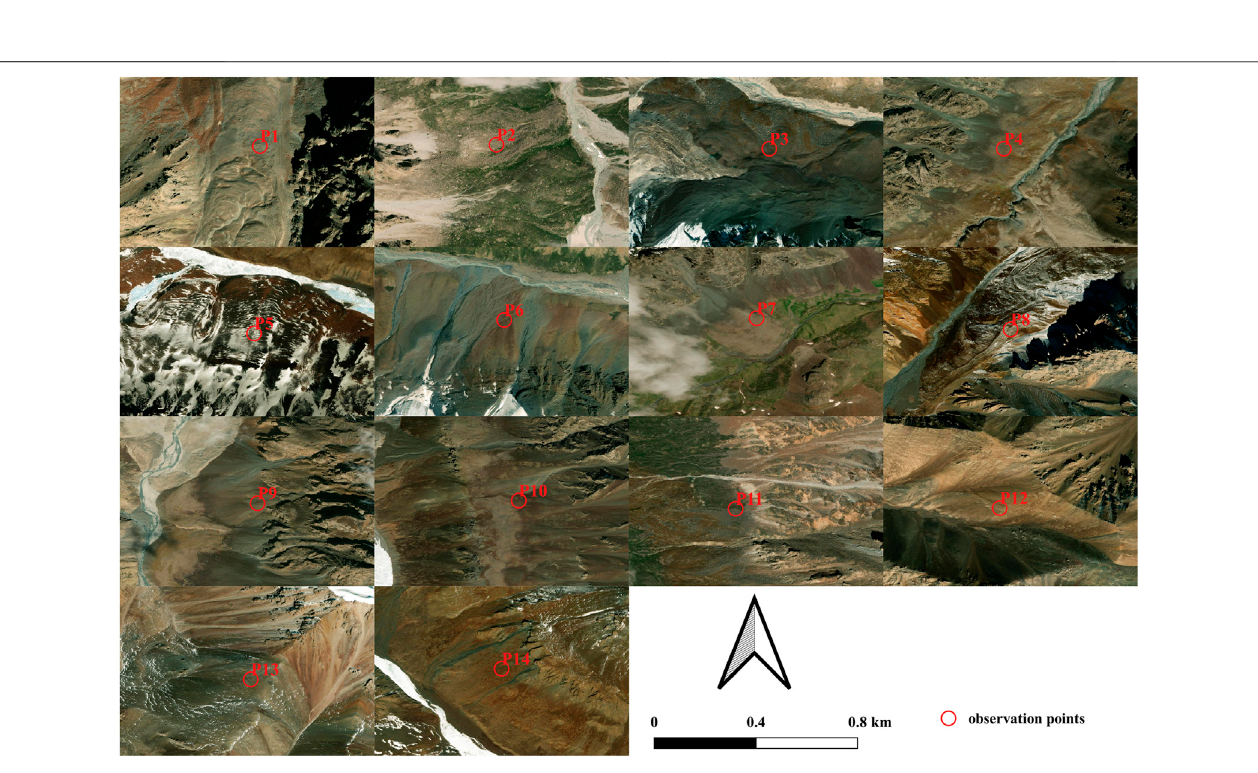
Frontiers in Earth Science |